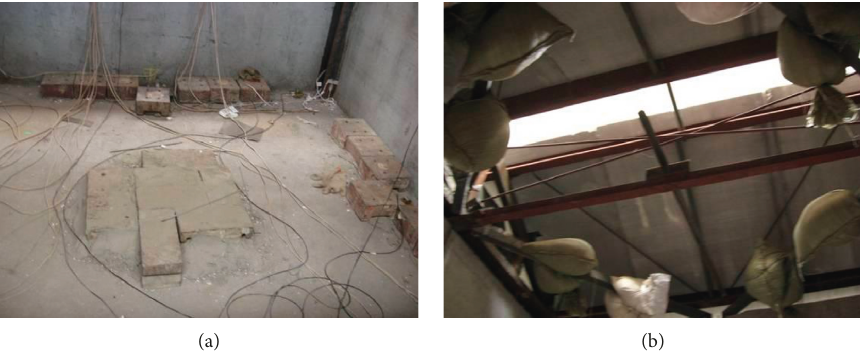
Figure 9: Simulating live load. (a) At floorslab of second floor. (b) At roof truss.